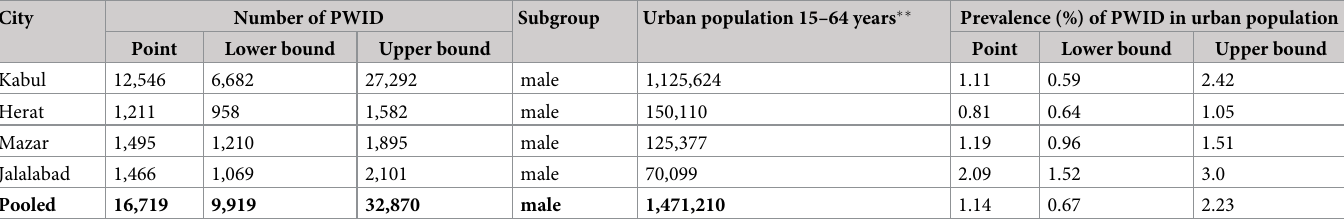
Table 2. Population sizes estimated for people who inject drugs (PWID) in different cities in Afghanistan in 2012 � using the unique object multiplier method. Esti- mates were used as priors for the Anchored Multiplier Bayesian synthesis of current estimates.